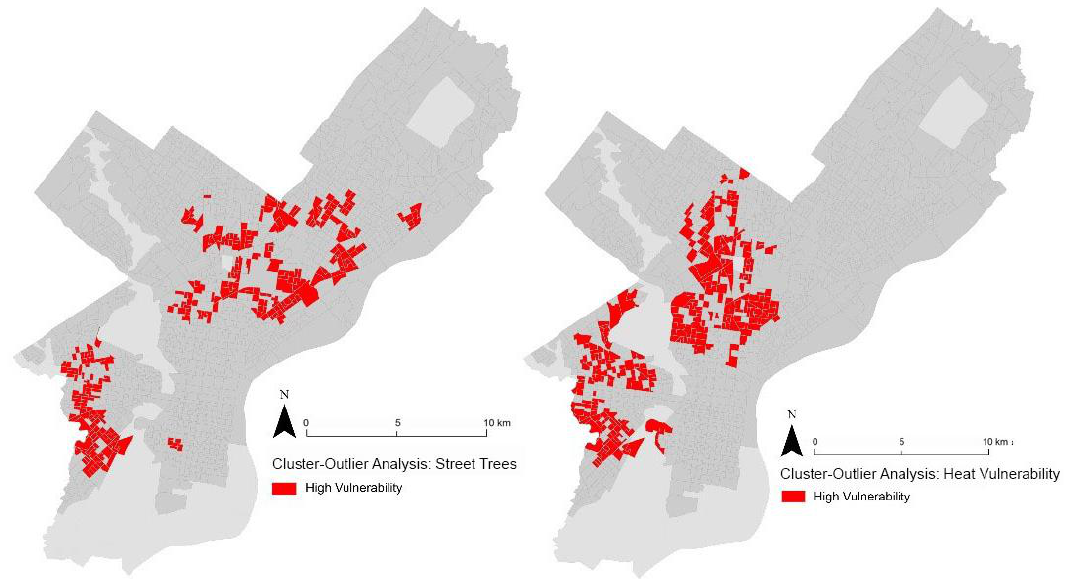
Figure 4. High vulnerability block groups as determined by Anselin Moran’s I (high-low cluster) analysis for street trees ( left ) and heat ( right ). These blocks represent areas of highest heat vulnerability and lowest numbers of street trees (or street tree vulnerability). Note: the light gray area represents areas of no data.